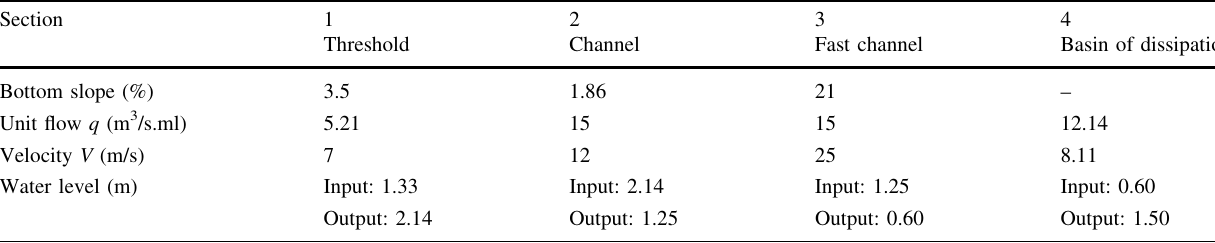
Table 1 Results of hydraulic calculations—lateral spillway